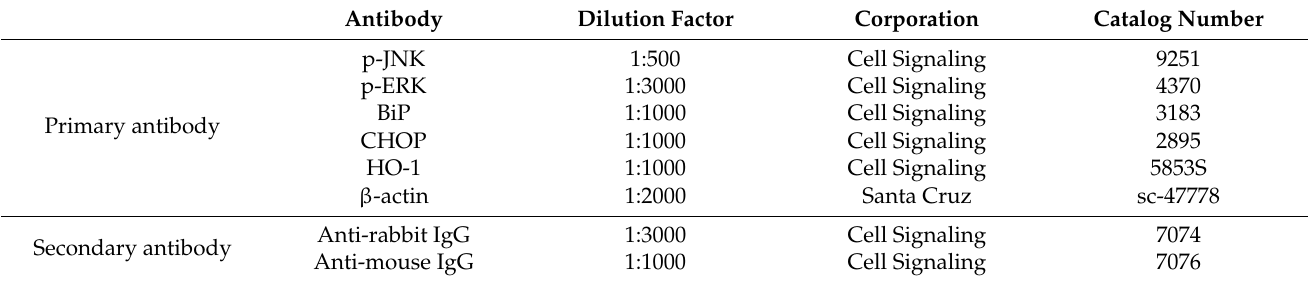
Table 6. List of antibodies for Western blot